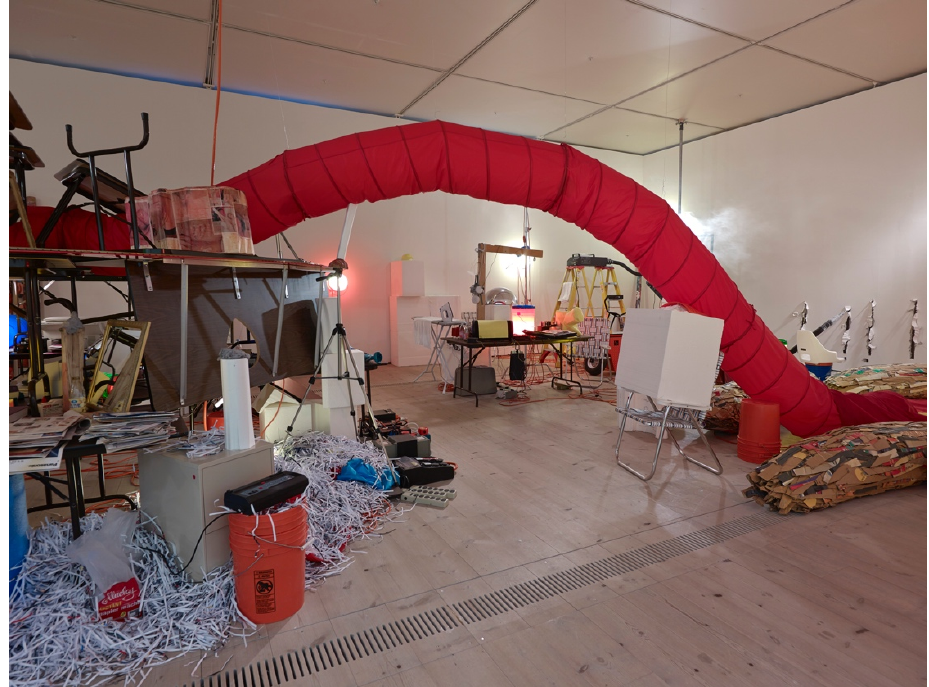
Figure 2. Jason Rhoades, The Creation Myth 1998/2015. Installation view. BALTIC Centre for Contemporary Art, Gateshead, United Kingdom. Friedrich Christian Flick Collection, Berlin. Photo: John McKenzie © 2022 BALTIC Centre for Contemporary Art.